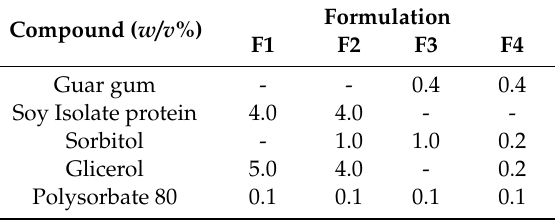
Table 1. Formulations for the preparation of guar gum and isolated soy protein edible films. Formulation Compound ( w / v %) F1